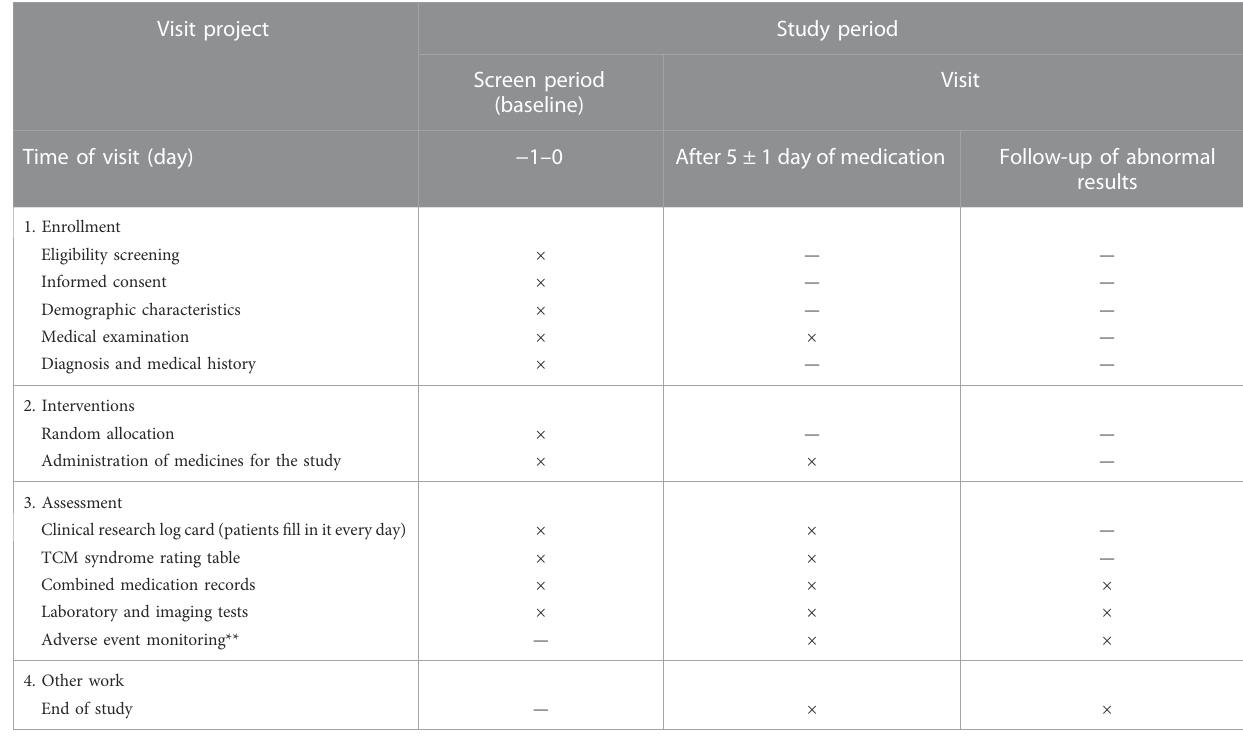
TABLE 1 Study plans of enrollment, intervention, and evaluation. Visit